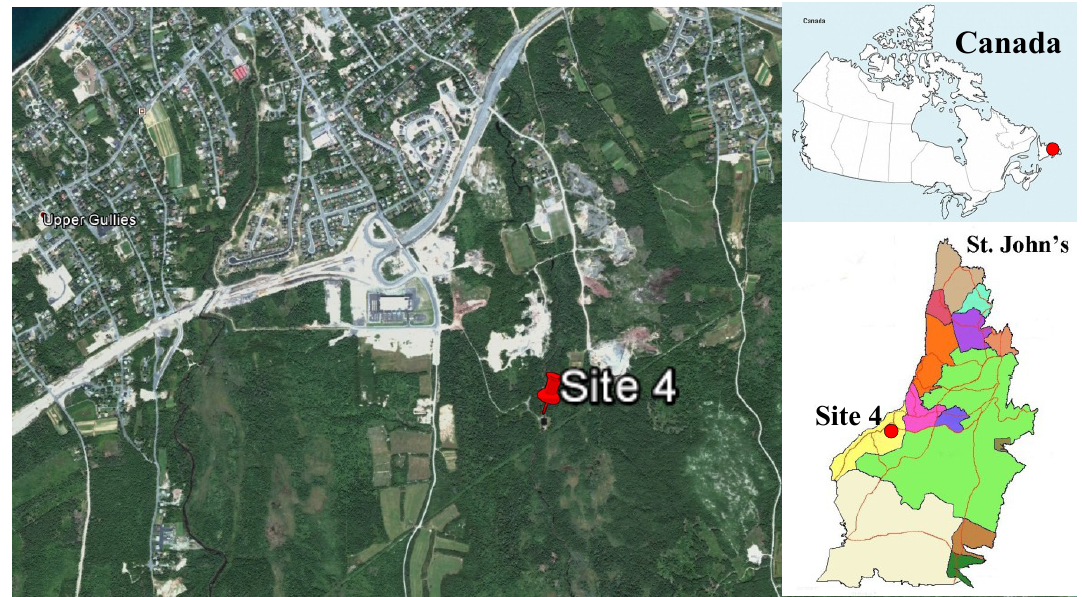
Figure 1. Site 4 location in the Kelligrews